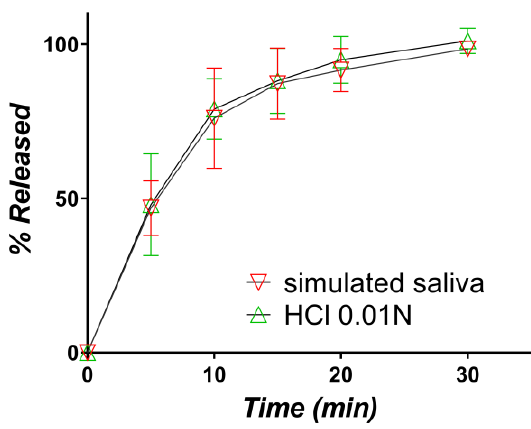
Figure 12. Comparative assessment of the in vitro release profiles of captopril from the orally disintegrating tablets containing the CAP- β -CD inclusion complex in simulated saliva (red) and 0.01 N (green) HCl, respectively.